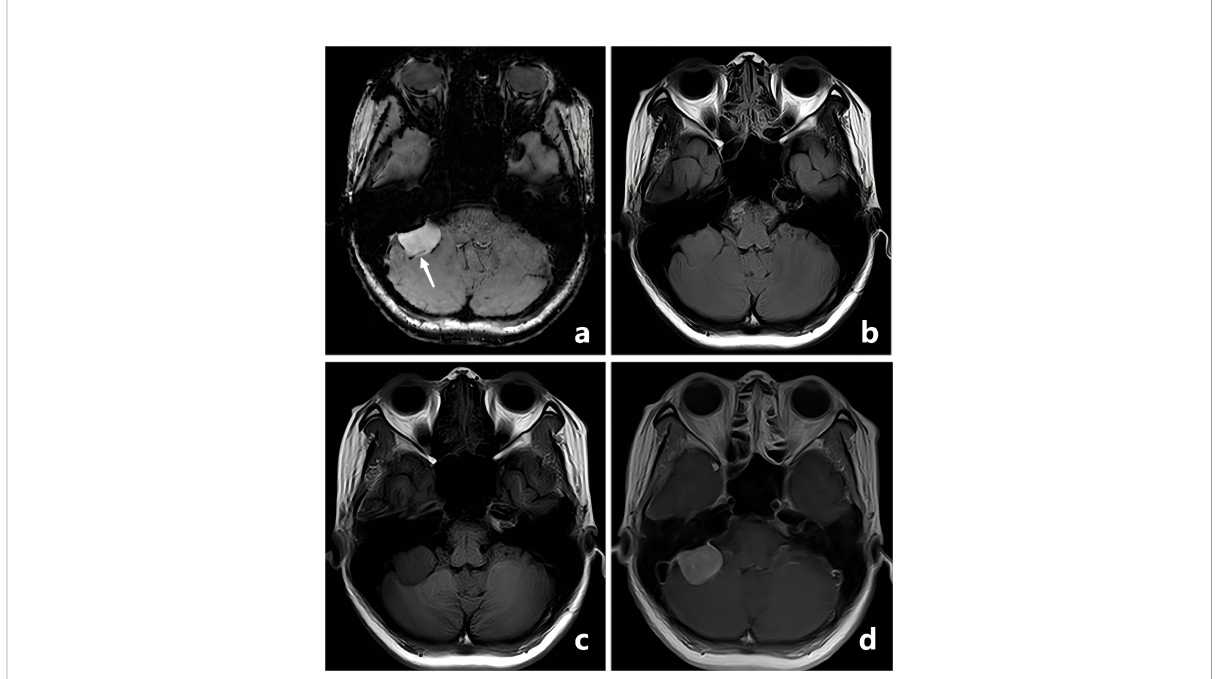
FIGURE 2 A-50-year-old woman with a pathologically con fi rmed meningioma in her right cerebellopontine angle area after surgical resection. The meningioma showed obvious homogeneous enhancement, and the intratumoral blood supply vessel appeared as linear hypointensity on CE-T 1 WI FSBB ( A , white arrow). FLAIR (B) , T 1 WI (C) , and CE-T 1 WI (D) showed no signs of blood